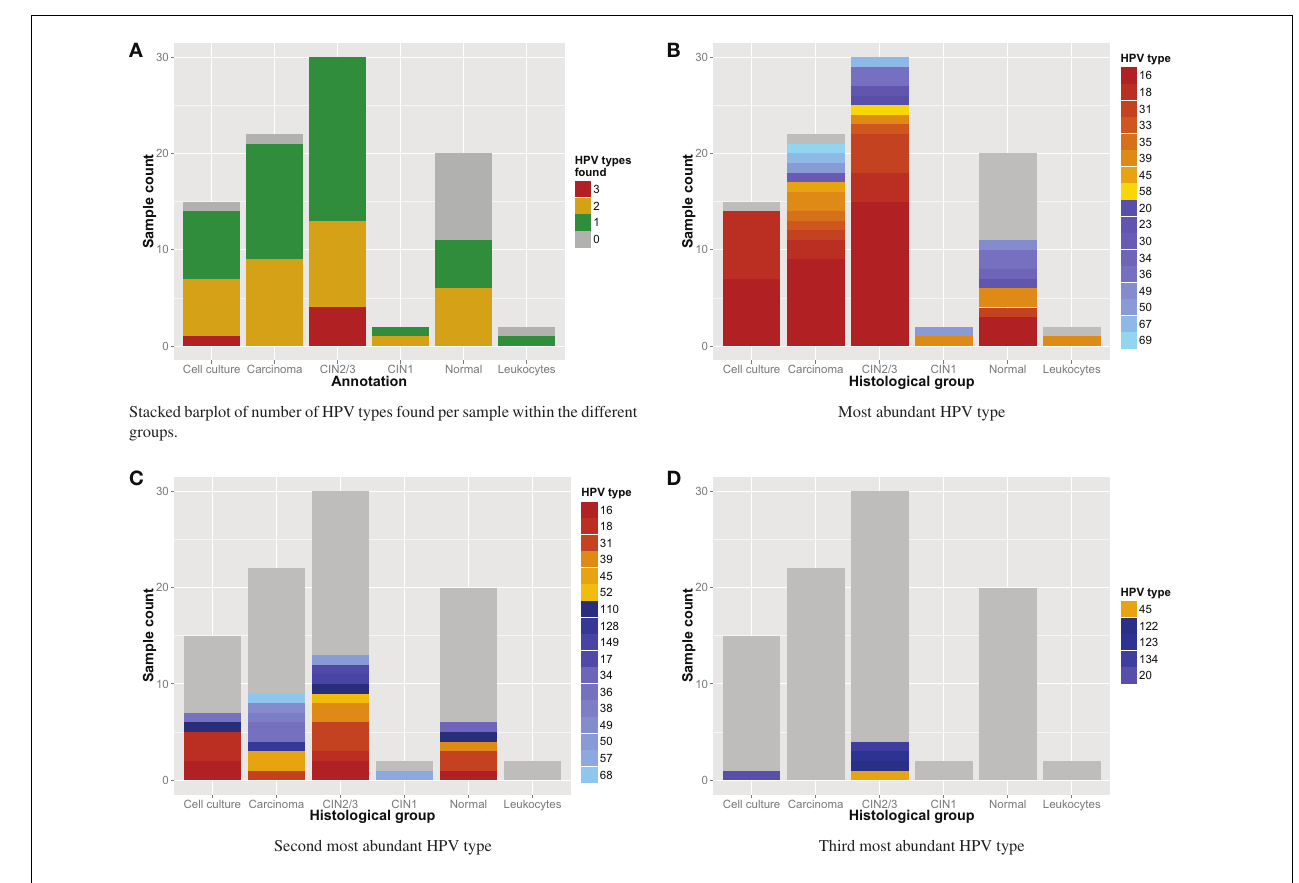
FIGURE 3 | (A) detection of HPV types: number of HPV types found per sample. (B–D) Stacked barplot of HPV types found per sample with n-th most fragments within the different groups. Red to gold and blue colored types correspond with respectively high and low risk HPV types.